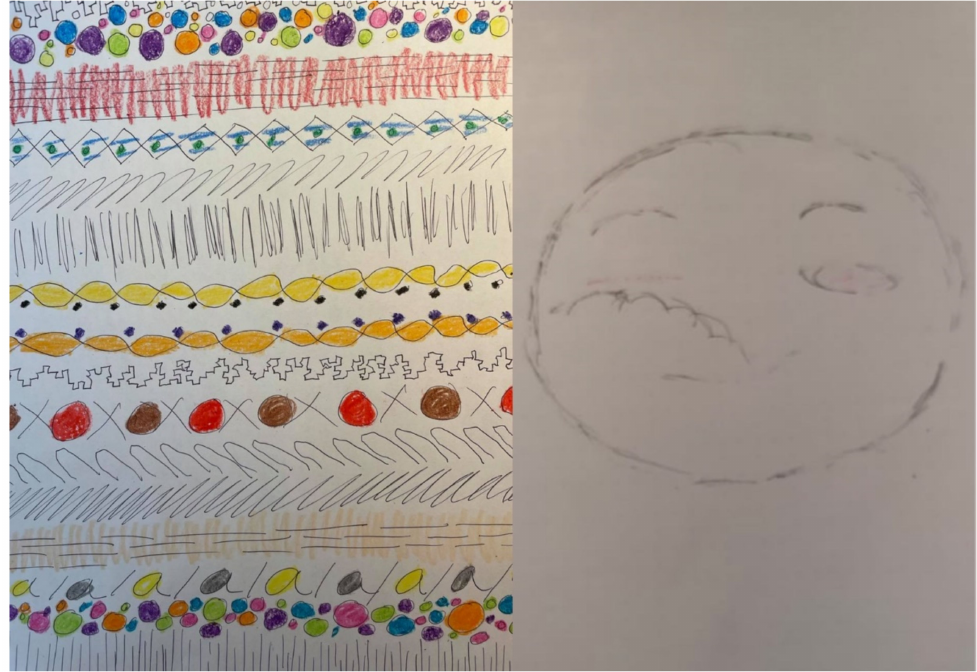
Figure 1. Doodle Provided by Facilitator ( Left ) and Participant ( Right ) After the First HeNReG Meeting of the 2021/2022 Academic Year Representing the Only Doodles Provided that